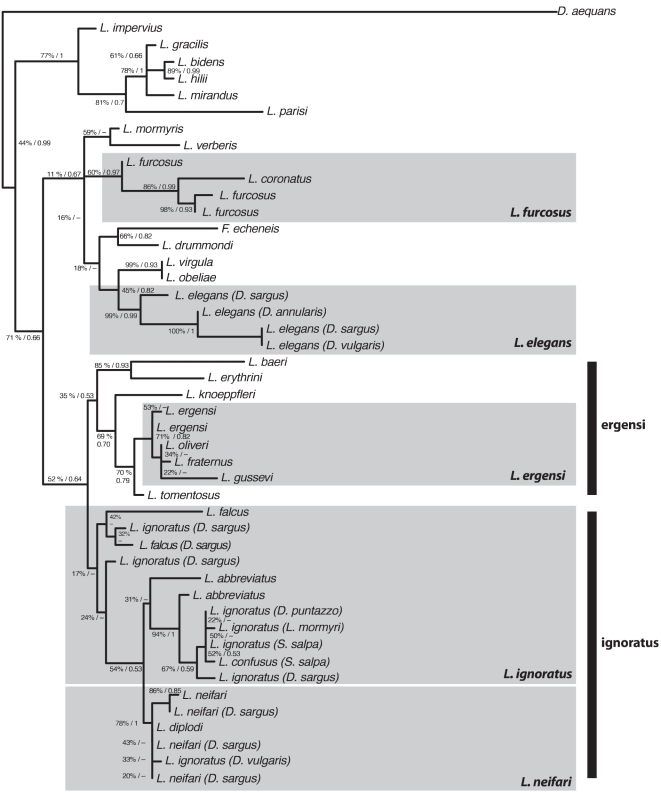
Phylogeny of several Lamellodiscus species obtained by maximum likelihood and Bayesian inference.As topologies obtained with both reconstruction methods gave congruent topologies and similar branch lengths, the most resolved tree, obtained by maximum likelihood, was retained and is presented here. Bootstrap values (1000 replicates) and posterior probabilities (>0.5. Dashes correspond to values <0.5) are indicated at each node. The clusters of individuals for which the alignment of ITS1 was possible are outlined in grey boxes. Thick black lines indicate ergensi and ignoratus groups.